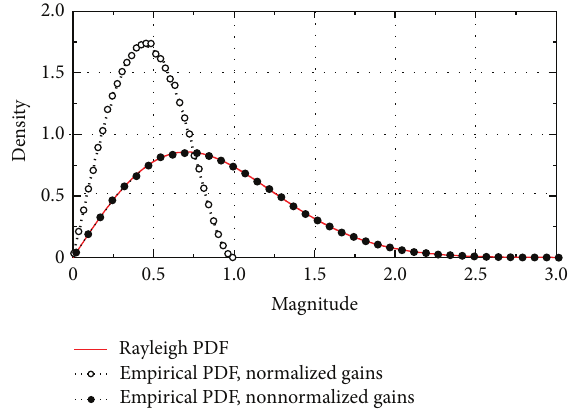
Figure 7: Rayleigh PDF and empirical PDFs of the magnitude of an entry of the normalized and nonnormalized channel Figure 6: Variation of the theoretical detection probability of the ST with four different realizations of the channel matrix, for 𝐾 = 4, = − 1 dB, SNR = − 3 dB, and SNR = − 10 dB. 𝑁 = 50, 𝑃 = 3, SNR 1 2 3 Scenario C: time-varying and normalized channel.